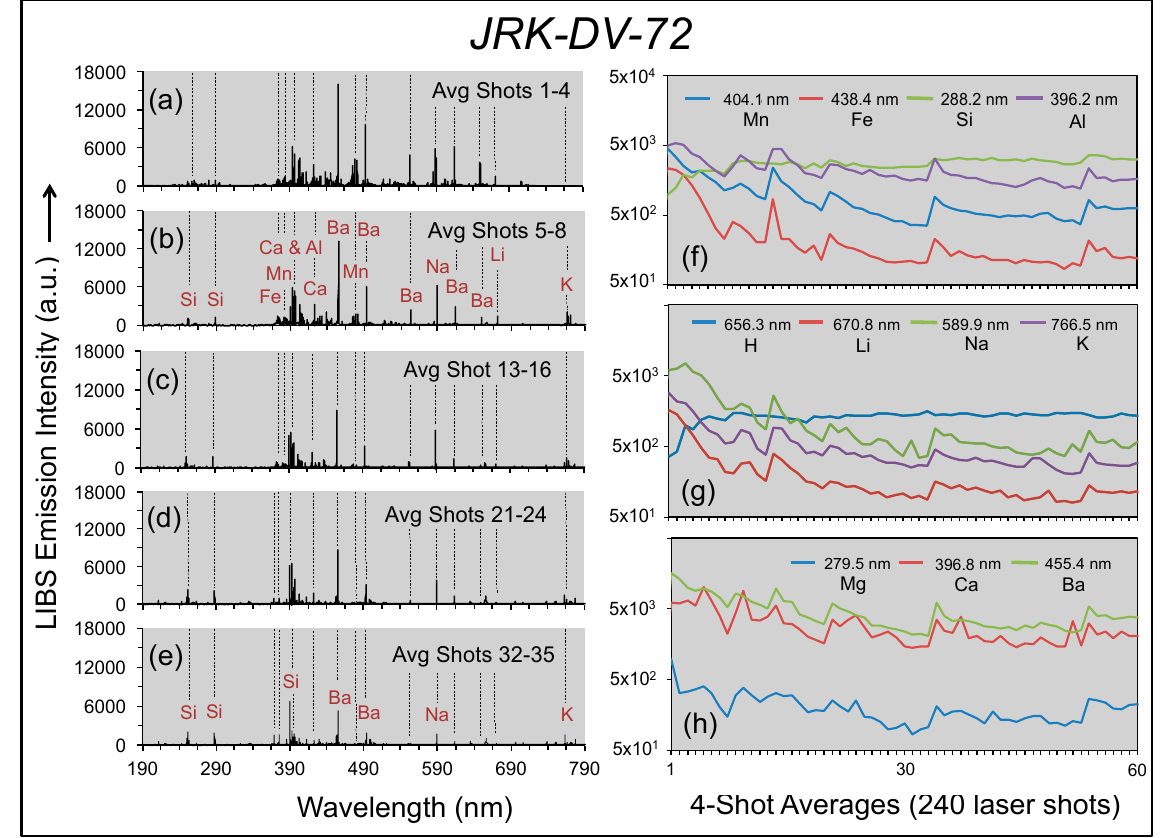
Figure 10. Depth profiles into the varnish layer of sample JRK-DV-72: ( a – e ) LIBS spectra for four-shot averages at five depths: shots 1–4 ( a ), shots 5–8 ( b ), shots 13–16 ( c ), shots 21–24 ( d ) and shots 32–35 ( e ); ( f – h ) emission line intensities for the 240 laser shot depth profile presented as semi-log plots for the 60 four-shot averages for Mn at 404.1 nm, Fe at 438.4 nm, Si at 288.2 nm and Al at 288.2 nm ( f ); H at 656.6 nm and alkali elements Li at 670.8 nm, Na at 589.0 nm and K at 766.5 nm ( g ); alkali earth elements Mg at 279.6 nm, Ca at 396.8 nm and Ba at 455.4 nm ( h